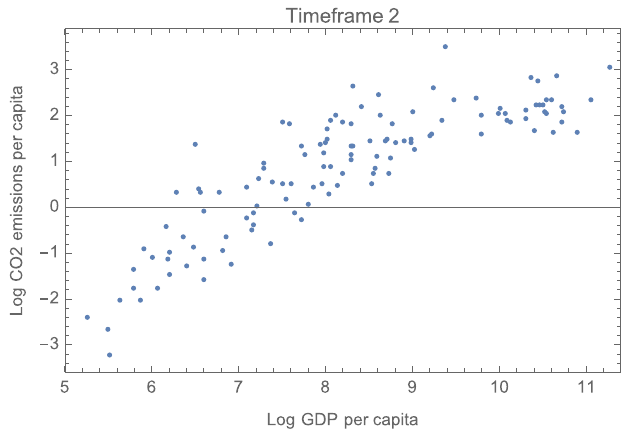
Fig. A.8. CO 2 as a function of log(GDP) in time frame 2 for all countries.